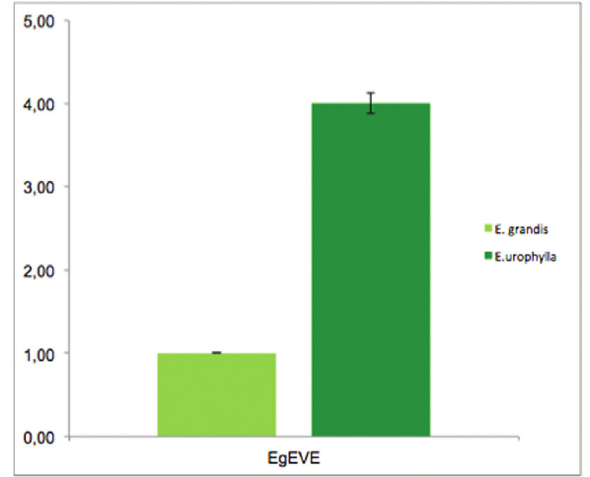
Figure 2 - EgEVE_1 RVT copies from E. grandis and E. urophylla using